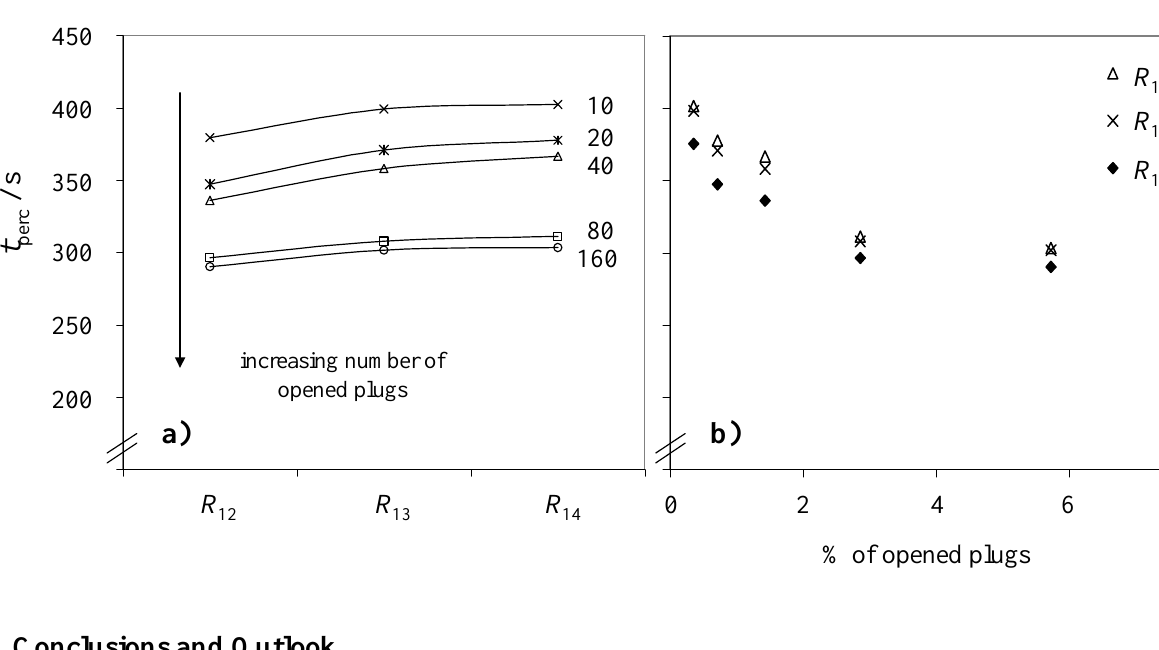
Figure 6. Percolation times of a planar soot sensor downstream of the DPF (a) in dependence of the electrode structure and (b) in dependence of the number of opened